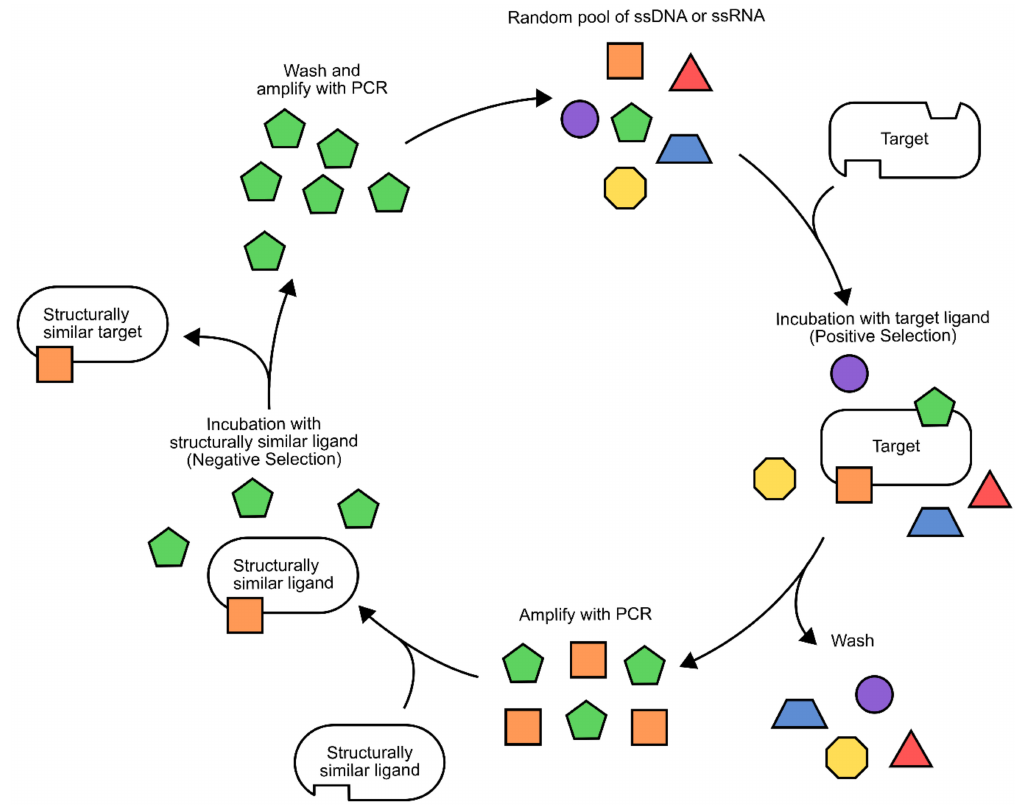
Figure 8. The systematic evolution of ligands by exponential enrichment (SELEX) process. The SELEX process uses a series of incubation and wash steps to identify single-stranded (ss) DNA or ssRNA molecules with binding affinity to a target ligand. Positive and negative selection steps are employed to avoid binding affinity to structurally similar compounds. Polymerase chain reaction (PCR) is used to amplify positive sequences and enrich them as a proportion of the total